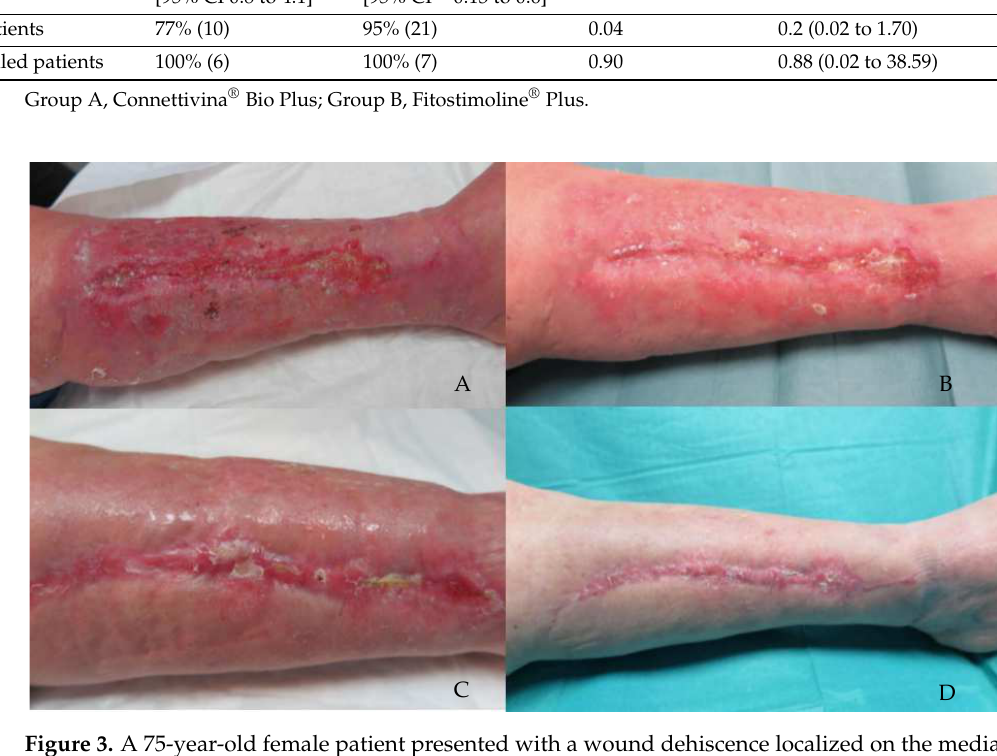
Figure 4. A 69-year-old female patient presented with a first- and second-degree burn lesion local- ized on the left side of the abdomen. The patient was randomly assigned to the group treated with Fitostimoline ® Plus cream and gauze. ( A ) Patient in V1, wound bed is covered with blisters; wound borders and perilesional skin are erythematous and edematous. ( B ) Patient in V3, wound area sen- sibly lessened (first-degree burn lesion); fibrin could be detected on the wound bed. Edema and erythema subsided significantly. ( C ) Wound in V5. ( D ) V6, wound healed completely.